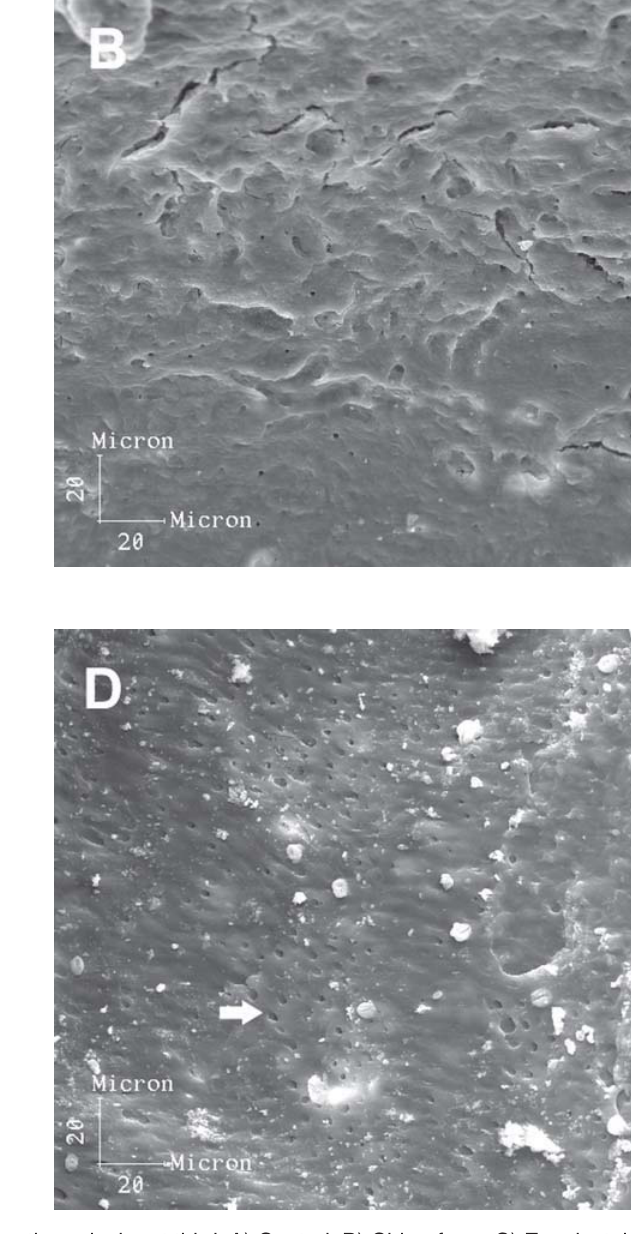
FIGURE 2- Representative SEM micrographs of samples from the apical root third: A) Control, B) Chloroform, C) Eucalyptol, D) Orange oil. Note the presence of only few open dentinal tubules (arrows). Original magnification